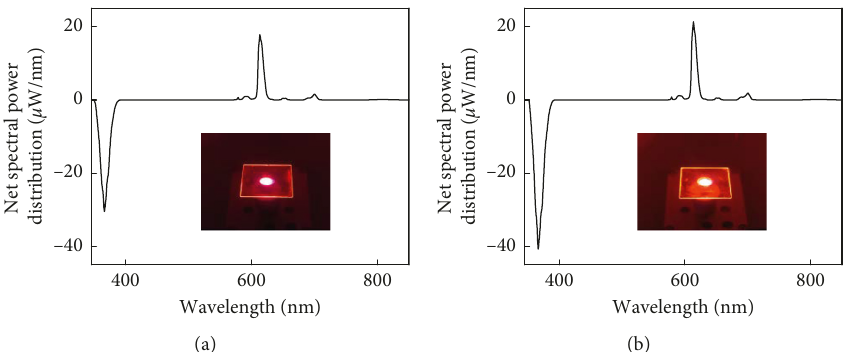
Figure 8: Net spectral power distributions of Eu(BA)(TTA) 2 /PVP (a) and Eu(BA)(TTA) 2 Phen/PVP (b) under 367nm UVA-LED ex- citation. Insets: fluorescence of Eu(BA)(TTA) 2 /PVP (a) and Eu(BA)(TTA) 2 Phen/PVP (b) in an integrating sphere under 367nm UVA-LED excitation.